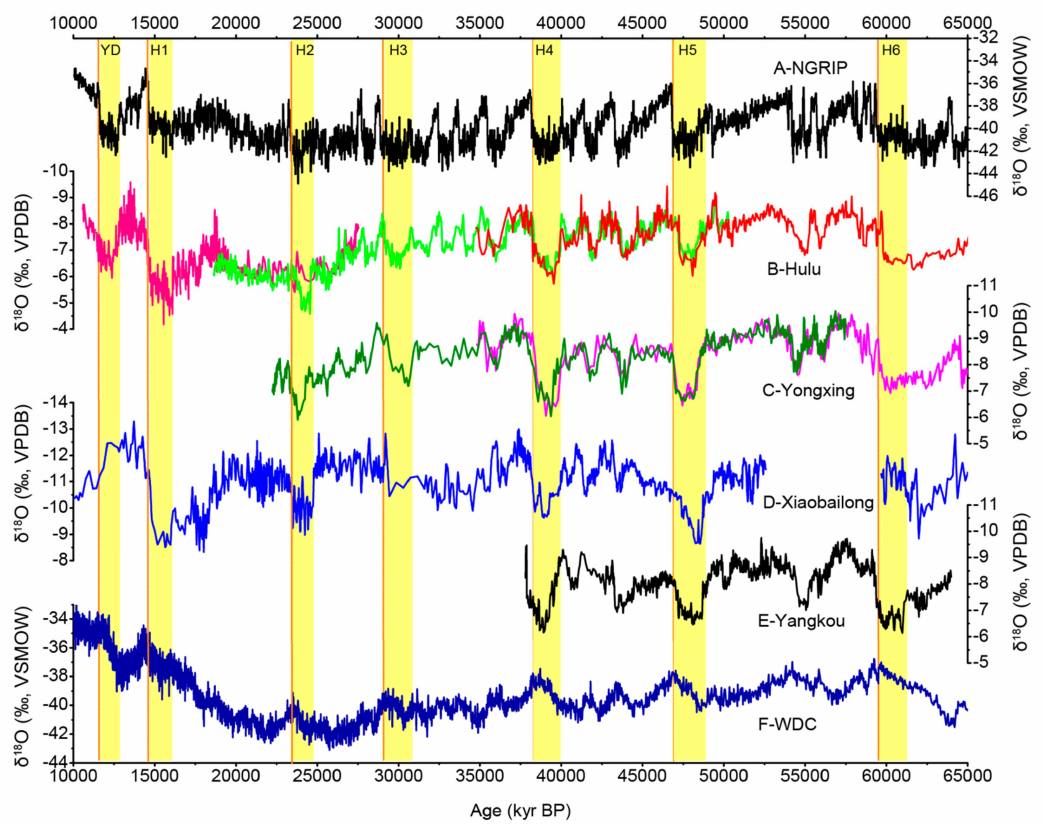
Figure 6. Comparison of Chinese speleothem δ 18 O records with bi-polar ice core δ 18 O records between 65 and 10 kyr BP. ( A ) NGRIP δ 18 O record [219]; ( B ) Hulu Cave (H82 in pink; MSD in green; MSL in red); ( C ) Yongxing Cave (YX51 in green; YX55 in pink; YX46 in purple); ( D ) Xiaobailong Cave; ( E ) Yangkou Cave; ( F ) WDC δ 18 O record from the Antarctic [220]. Yellow bars indicate Younger Dryas (YD) and Heinrich events (H1–H6) which occurred in the North Atlantic